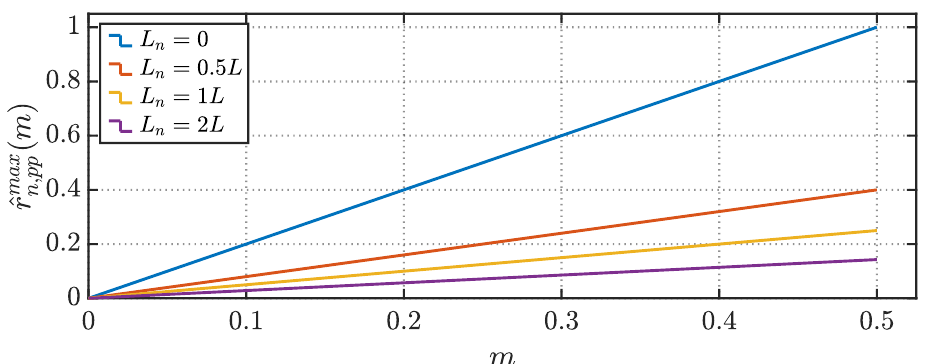
Figure 13. Maximum, normalized, peak-to-peak neutral switching current ripple as a function of modulation index m at specific inductance values of the neutral line inductor.